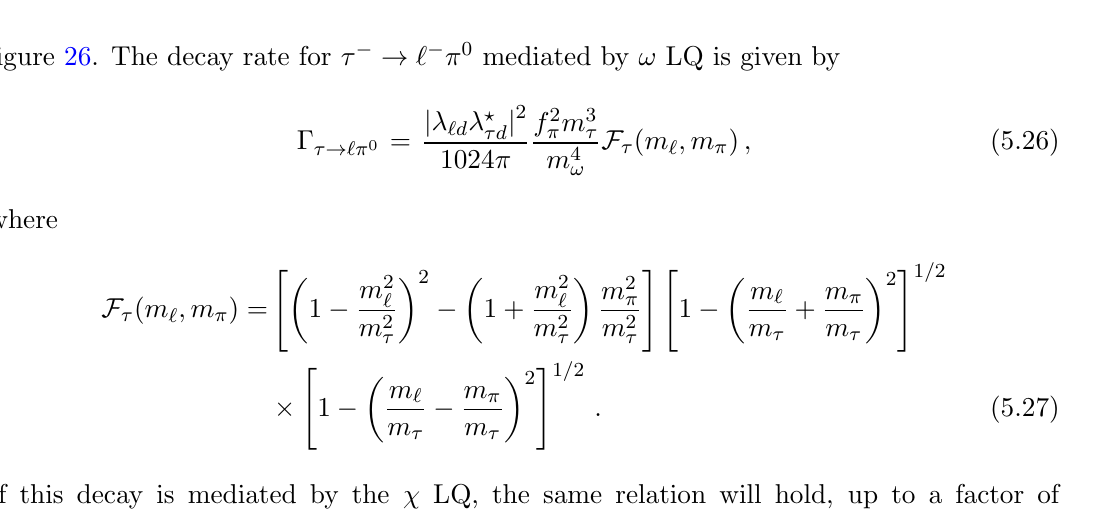
e(cid:25) 0 ( e(cid:17) , e(cid:17) 0 ) !